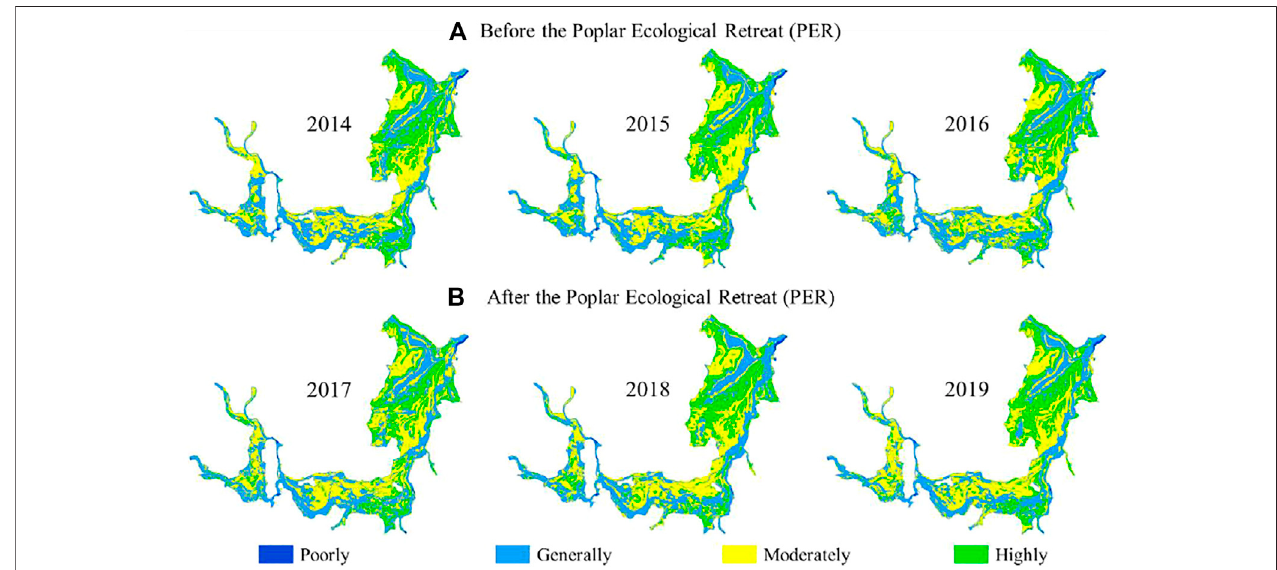
FIGURE 3 | The habitat suitability maps for Anatidae of (A) before PER (B) after PER, the habitat suitability maps for Charadriidae, Ardeidae and Laridae are showing in Supplementary Figure S2 – 4 .